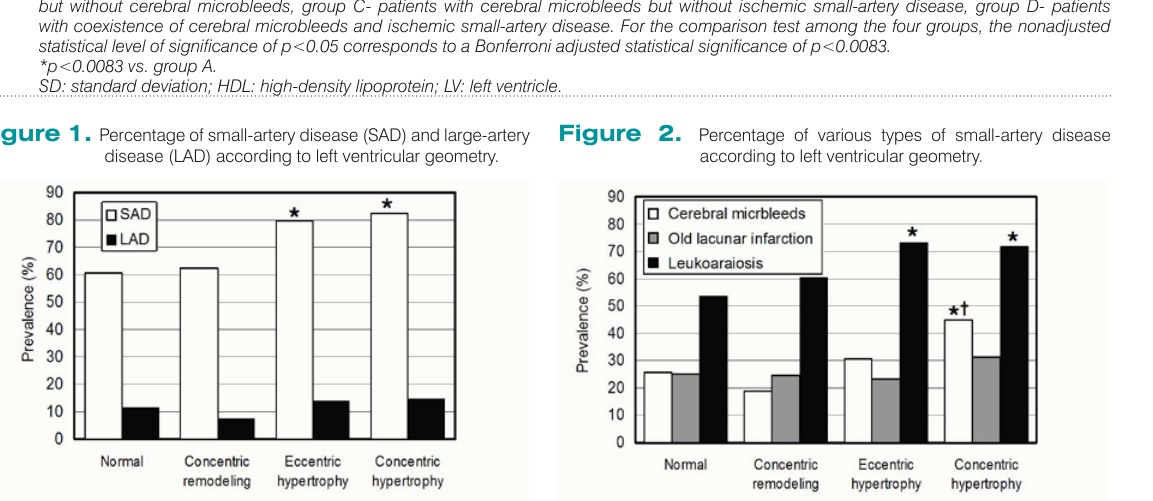
For the comparison test among the four groups of left ventricular geometry, the nonadjusted statistical level of significance of p<0.05 corresponds to a Bonferroni adjusted statistical significance of p<0.0083. *p<0.0083 vs. normal geometry, †p<0.0083 vs. concentric remodeling.